Question: Write a single sentence explaining what this figure depicts.
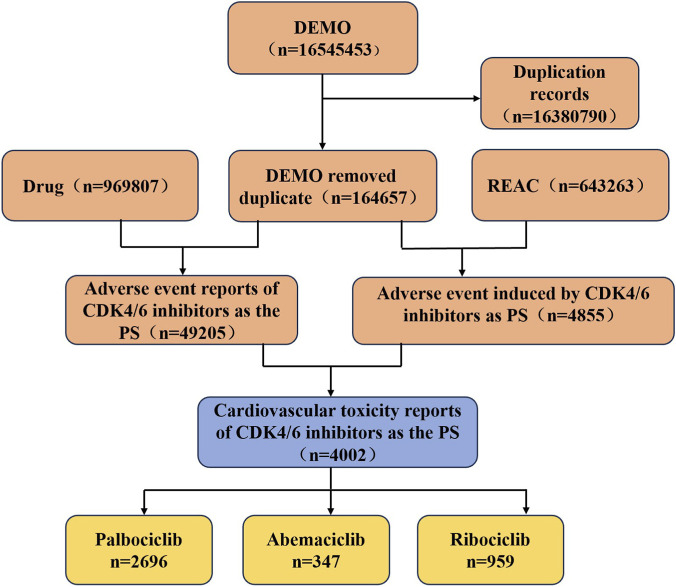
Answer: Process of selecting cases of CDK4/6 inhibitors-associated CV from the FAERS database. Abbreviations: DEMO, demographic and administrative information; REAC, reactions; n: the number of reports; PS, primary suspect.